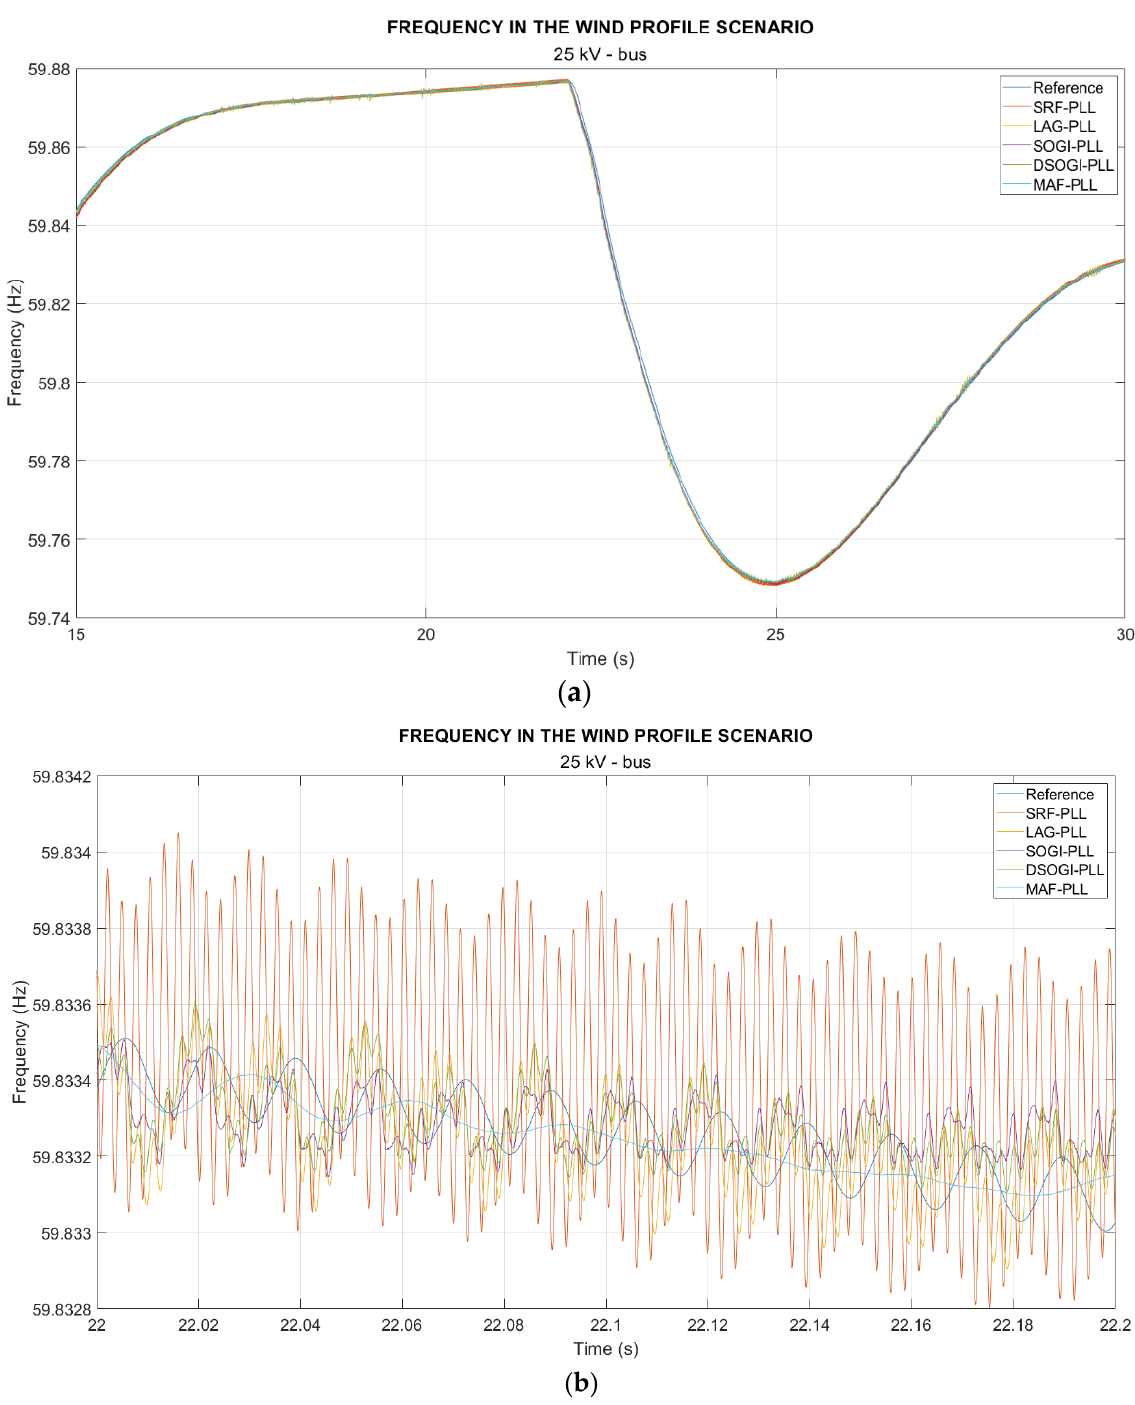
Figure 15. Frequency measurement with the PLLs located at the 25 kV WinGen bus: ( a ) PLLs measuring from seconds 15 to 35, and ( b ) detail of the measurements from seconds 22 to 22.2.